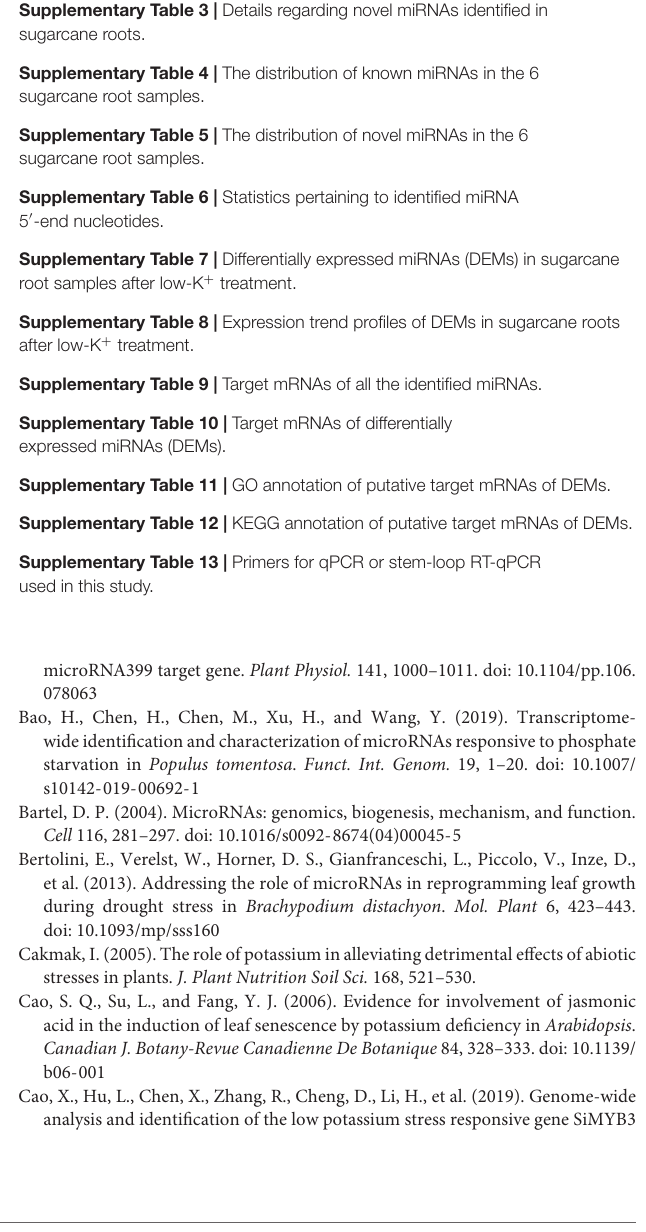
Supplementary Table 2 | Details regarding known miRNAs identified in sugarcane roots. Supplementary Table 3 | Details regarding novel miRNAs identified in sugarcane roots. Supplementary Table 4 | The distribution of known miRNAs in the 6 sugarcane root samples. Supplementary Table 5 | The distribution of novel miRNAs in the 6 sugarcane root samples.